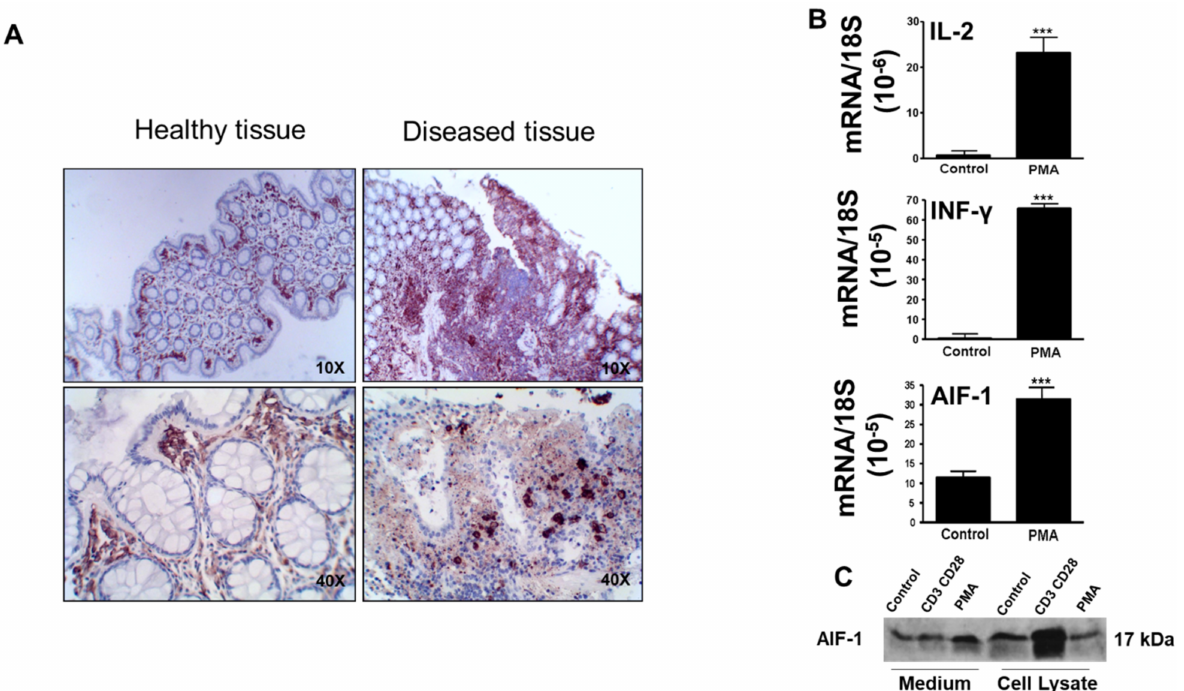
Figure 3. AIF-1 levels in human colon biopsies from CD patients and in human PBMC after stimu- lation with PMA. ( A ) Comparison of AIF-1 levels between the affected and healthy areas in colon biopsies of patients with CD. ( B ) Study of AIF-1 mRNA levels in PBMCs after stimulation with PMA. The results have been compared with the other cytokines (IL-2 and INF- γ ). ( C ) AIF-1 protein levels in PBMCs after the stimulus with PMA. Significance levels: *** p <